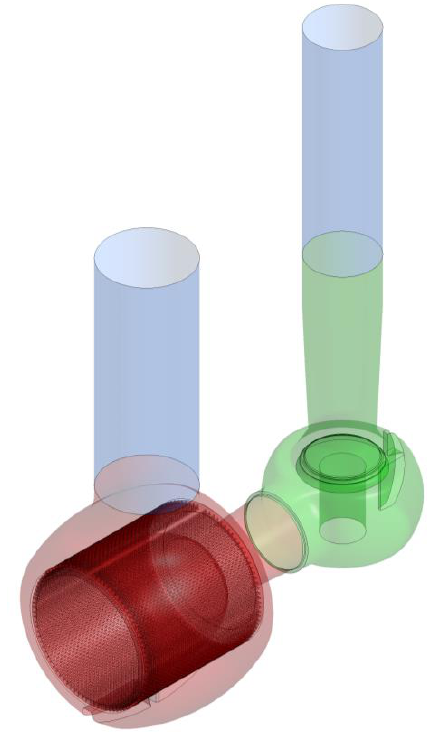
Fig. 5. Compact valve model assembly with the control valve chamber with greater space